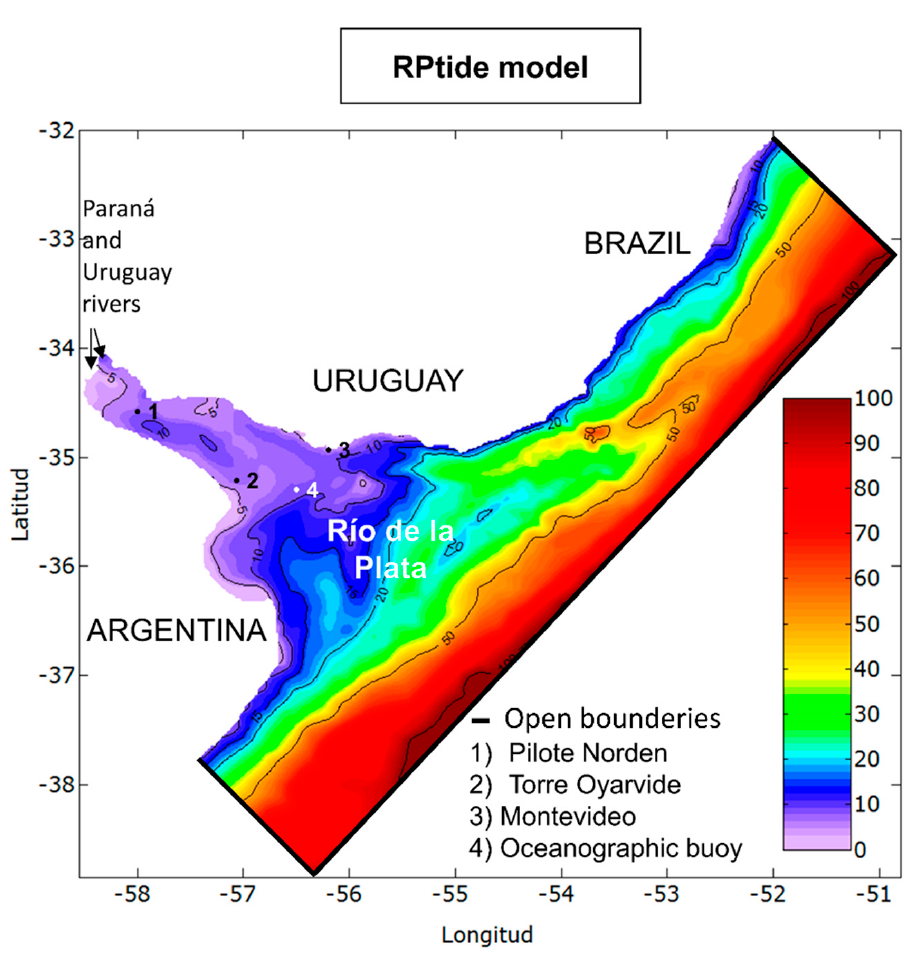
Figure A1. RPtide model domain, bathymetry (m), and location of stations. Table A1. RPtide model calibration test and range parameters. Ref is the reference simulation; for the other simulations, only the modified parameters are shown. The parameters for the selected configuration after the calibration process are referred to as Final.